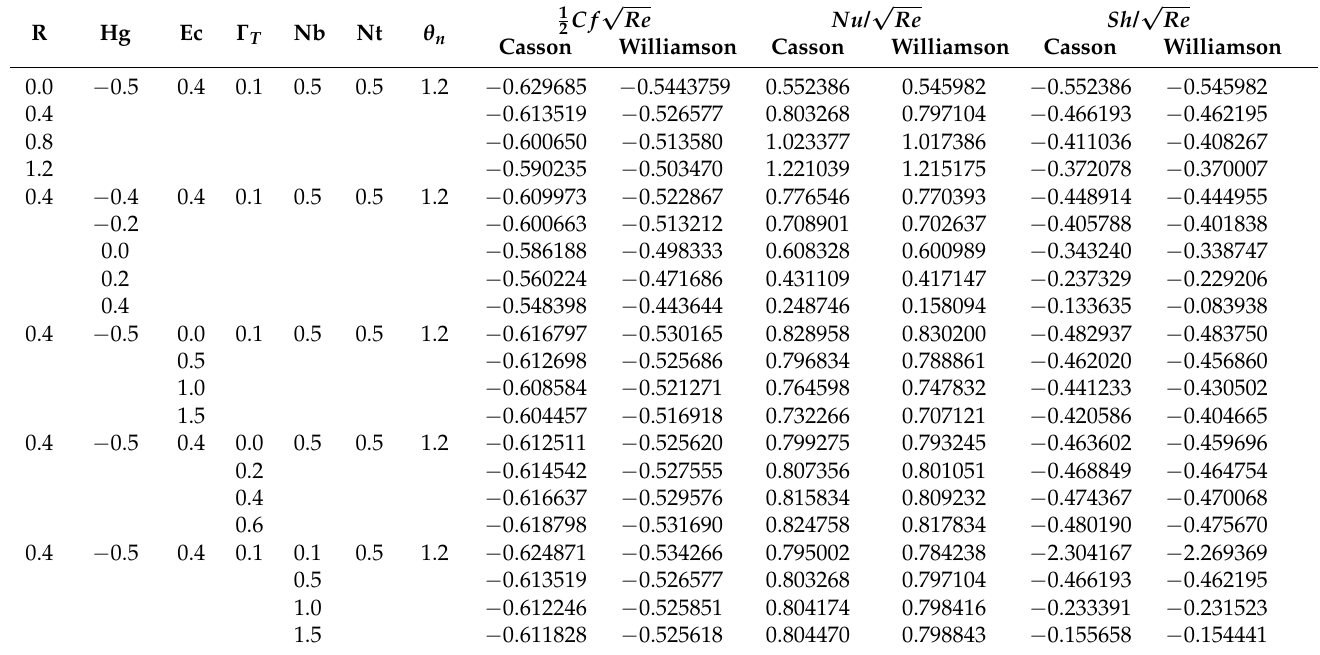
Table 2. The skin friction coefficient, local Nusselt number and local Sherwood number for R , Hg , Ec , Γ T , Nb , Nt and θ n for both